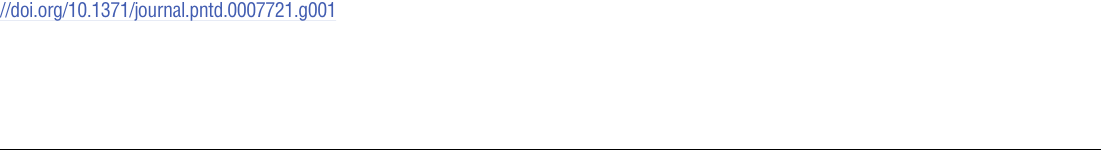
PLOS NeglectedTropical Diseases | https://doi.org/10.1371/journal.pntd.0007721 September 23,